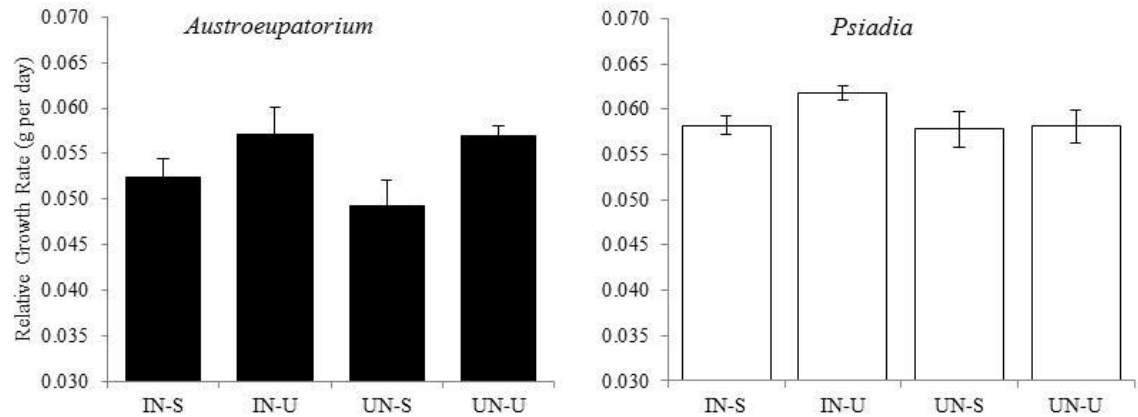
Figure 3: Relative growth rate (g per day) of Austroeupatorium and Psiadia grown under differently-treated soils; invaded/sterilized (In-S), invaded/un-sterilized (In-U), un-invaded/sterilized (Un-S) and un-invaded/un-sterilized (Un-U). Error bar represents the standard error of the mean (SEM) values (ANOVA; F=0.001, p=0.998, df=5).